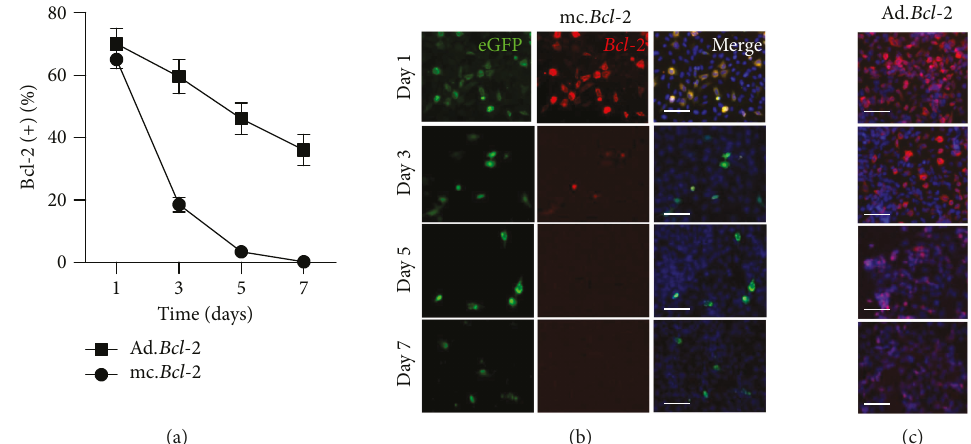
Figure 1: Time course of transient Bcl-2 expression in NSCs. (a) Flow cytometric quanti fi cation of Bcl-2 positive cells over 1 week posttransfection with minicircle constructs (circle) or posttransduction with adenovirus (square). (b-c) Representative immuno fl uorescent images demonstrating a decline in eGFP and Bcl-2 expression in both minicircle-transfected (b) and adenovirally transduced NSCs (c) over 1 week. Scale bars in both (b) and (c) =50 μ